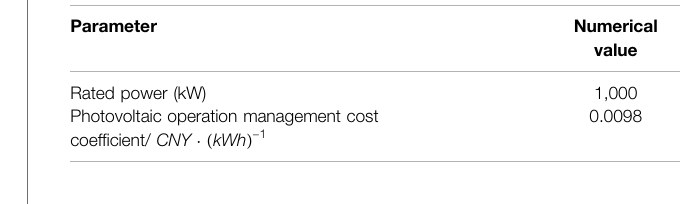
TABLE 2 | Basic parameters of photovoltaics.